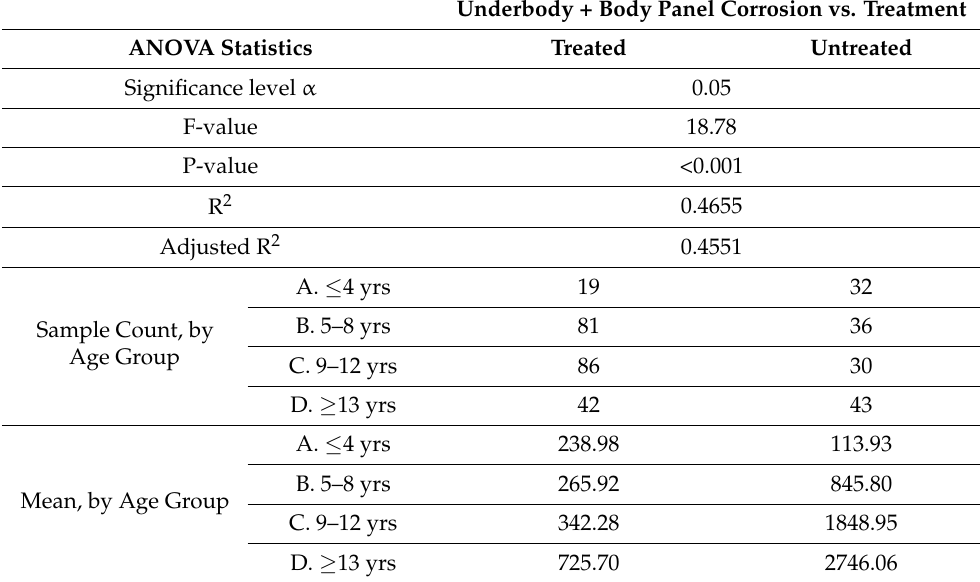
Table 3. Summary of statistics for two-factor ANOVA analysis of corrosion index versus vehicle age group and treatment for treated and untreated